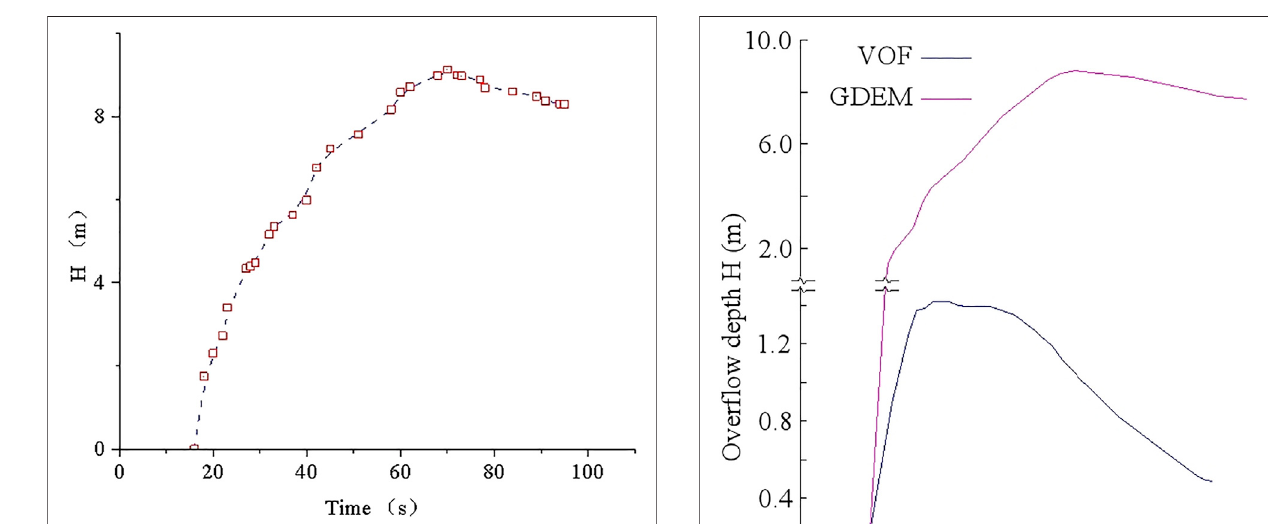
FIGURE 12 | The over fl ow depth of the comprehensive building.